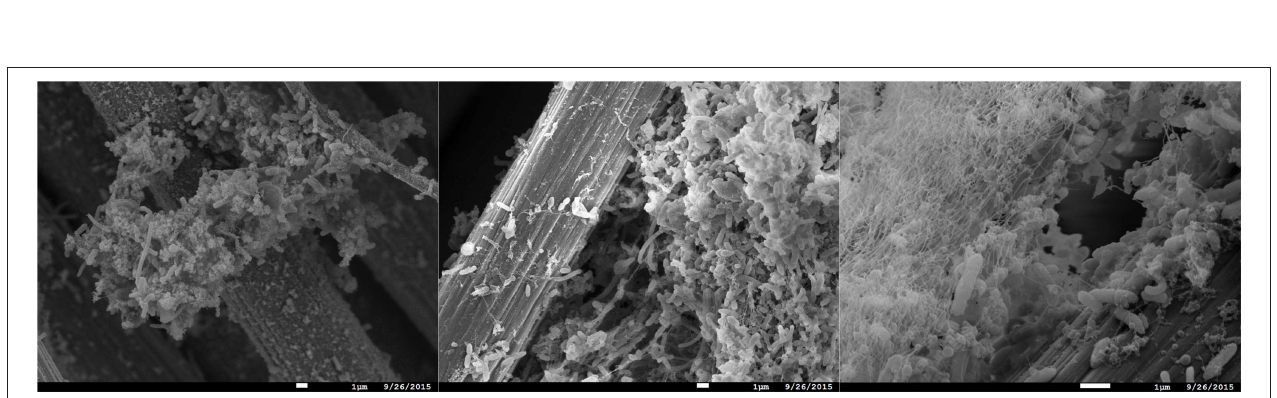
FIGURE 5 | Scanning electron micrograph of the enrichment electrode-associated biomass at WE1 at − 0.19V vs. SHE (left) , WE2 at + 0.01V vs. SHE (center) , and WE4 at 0.53V vs. SHE (right) (scale = 1 µ m).